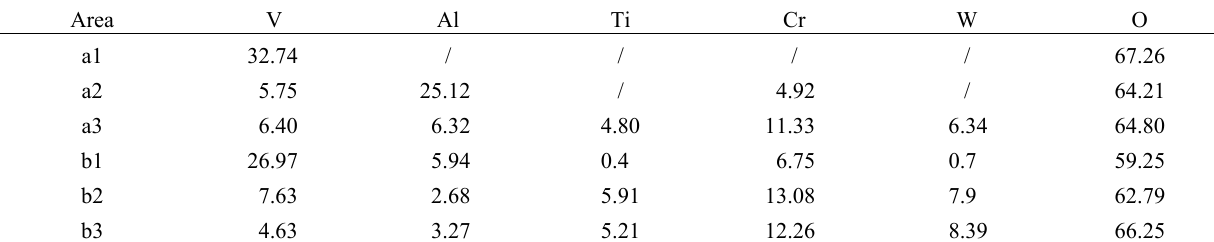
Table 2 Atomic percentages of elements in different regions (at%) marked in Figs. 7(a) and 7(b). Area V Al Ti